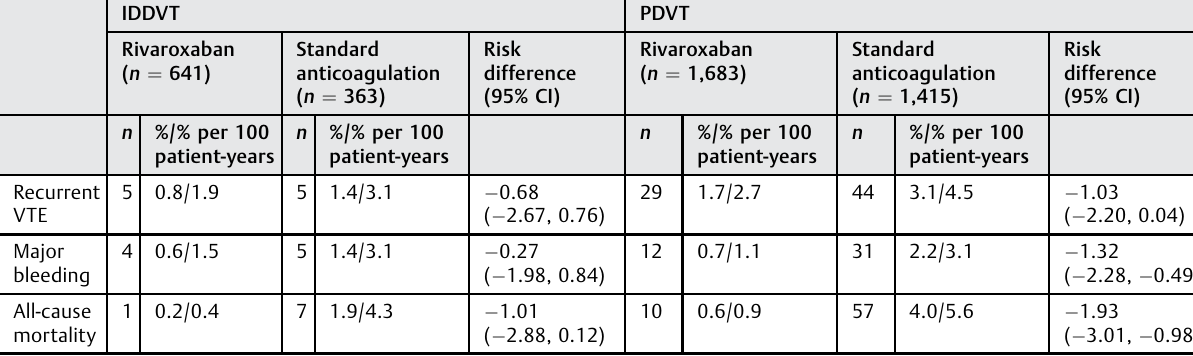
Table 5 Treatment-emergent primary outcomes in patients with IDDVT or PDVT in the safety analysis set treated with standard anticoagulation or rivaroxaban